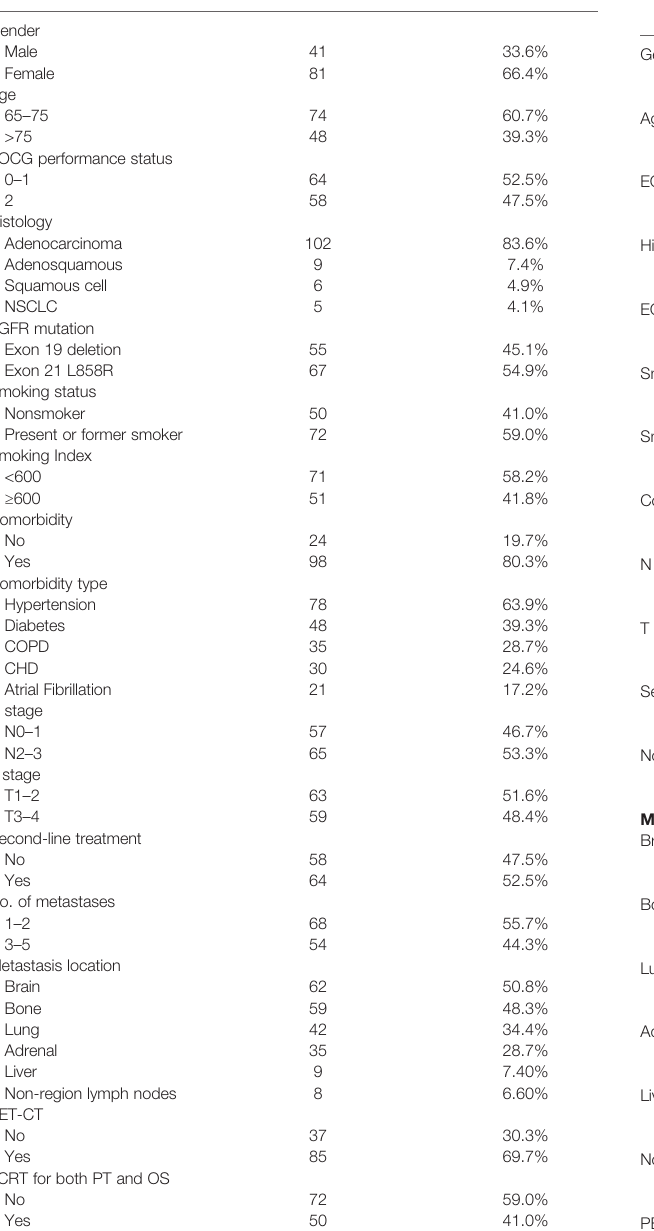
TABLE 1 | Baseline patient characteristics. TABLE 2 | Patients characteristics of tkis alone group and LCRT + TKIs group.